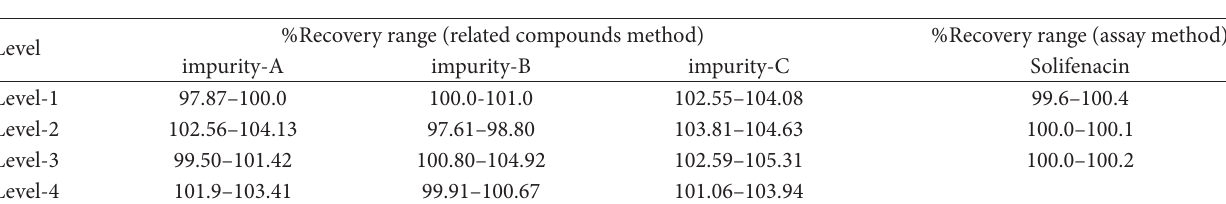
T 5: Summary of recovery